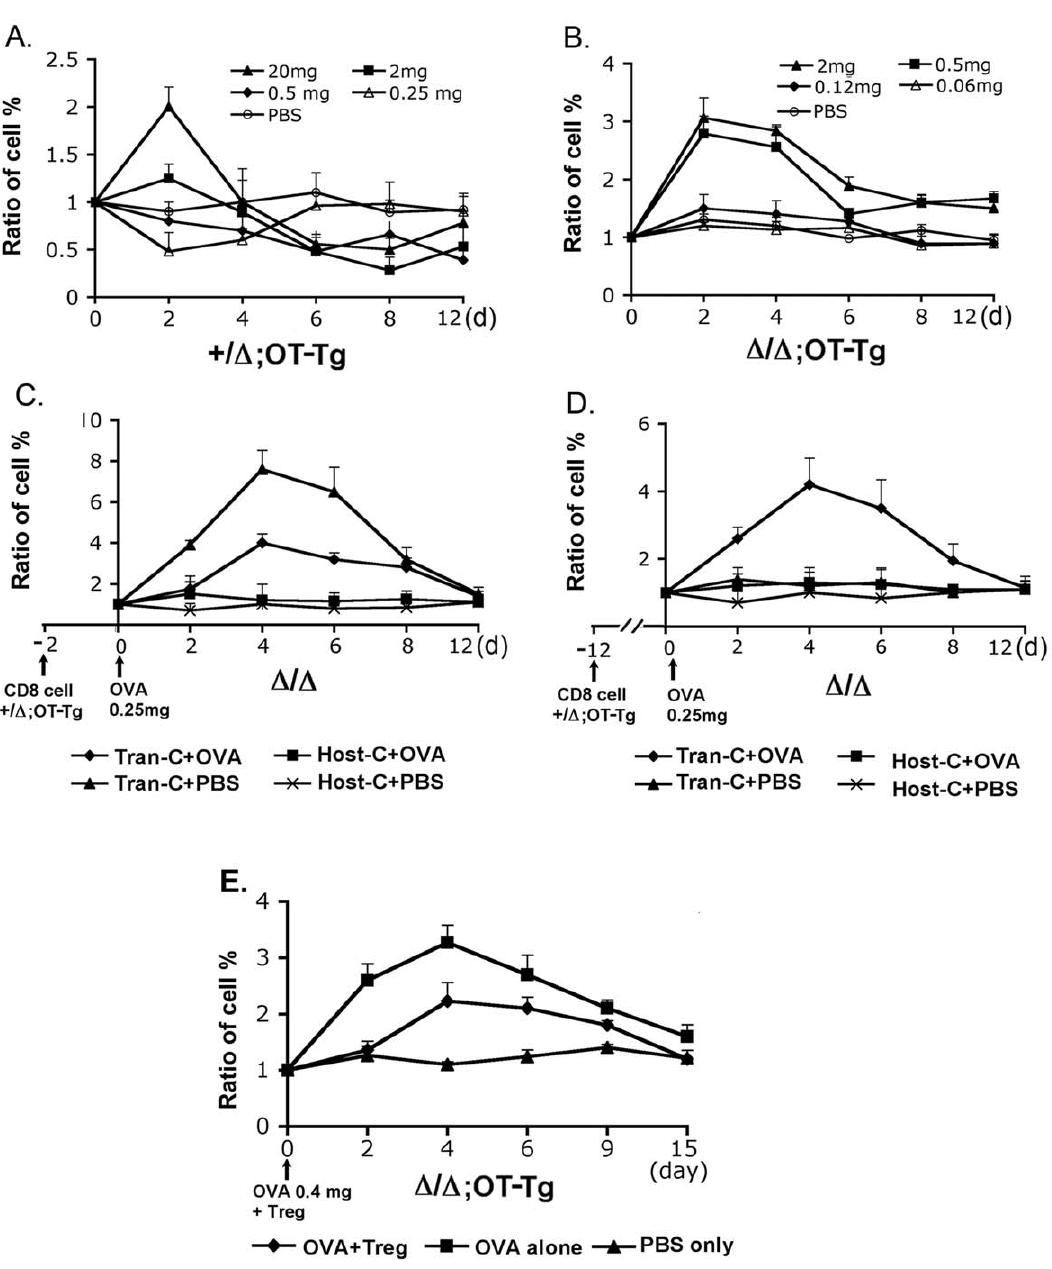
Figure 8. Foxn1 D / D ;OT1 Tg CD8 cells have a high sensitivity response to OVA protein in Foxn1 D / D ;OT1 Tg mice. All results are shown as a ratio of the percentage of OT1 Tg CD8 T cells on the indicated day relative to day 0. A and B, kinetic response of OT1 Tg CD8 T cell to serial doses of OVA. The Foxn1 + / D ;OT1 Tg ( + / D ;OT-Tg) and Foxn1 D / D ;OT1 Tg ( D / D ;OT-Tg) mice received a single retro-orbital injection of OVA from 0.06 to 20 mg, and CD8 Tg T cells in individual mice were analyzed at the indicated day. C and D, response of transferred Foxn1 + / D ;OT1 Tg CD8 T cells to OVA in Foxn1 D / D mice. 2 6 10 6 sorted Foxn1 + / D ;OT1 Tg CD8 T cells were transferred into Foxn1 D / D mice. 1 day (C) and 10 days (D) later, the percentage of OT1 Tg CD8 cell was measured as day 0 andthen OVA 250 m g per mouse was injected. The percentage of OT1Tg CD8 T cells was continuously measured at theindicated day after OVA injection. Results shown were the average volume from two or three individual experiments. E, the hypersensitive response of Foxn1 D / D ;OT1 Tg CD8 T cells was partially suppressed by the transferred CD4 + CD25 + regulatory T cells. Sorted CD4 + CD25 + T cells were retro-orbitally transferred into Foxn1 D / D ;OT1 mice combining with OVA 400 m g per mouse. The results shown were the average volume from two individual experiments.